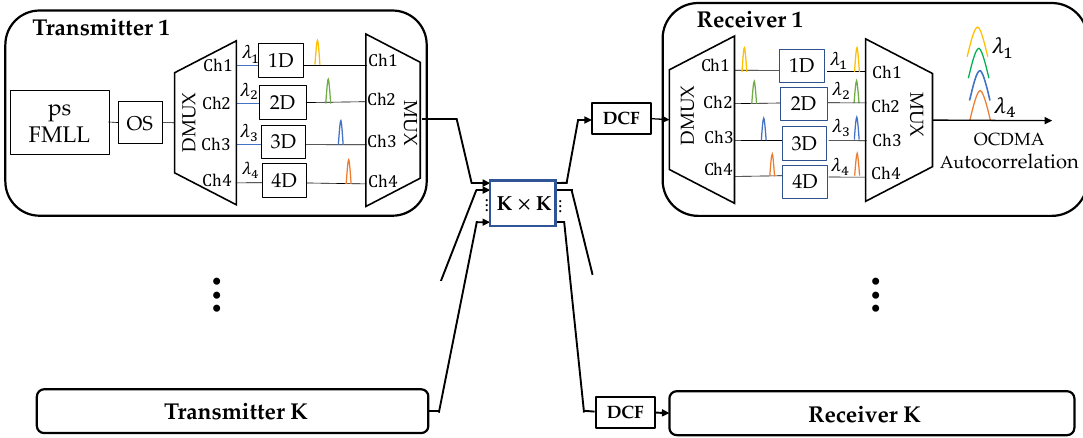
Figure 1. Schematic diagram of the experimental setup with illustration of two-dimensional wavelength-hopping time-spreading (2D-WH / TS) code carriers in frequency (FD, top) and time (TD, bottom) domain, respectively. TD—time domain, FD—frequency domain, ps FMLL—picosecond fiber mode locked laser, OS—optical supercontinuum, DMUX—de-multiplexer, MUX—multiplexer, SOA—semiconductor optical amplifier, DCF—chromatic dispersion compensating fiber.